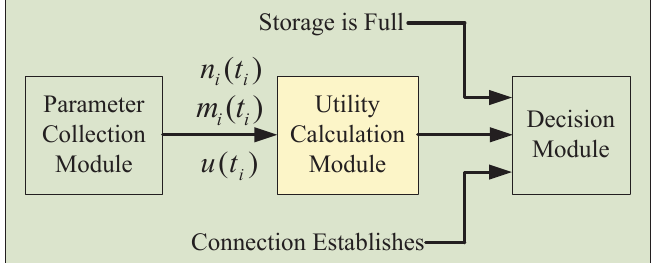
Figure 3. The storage management